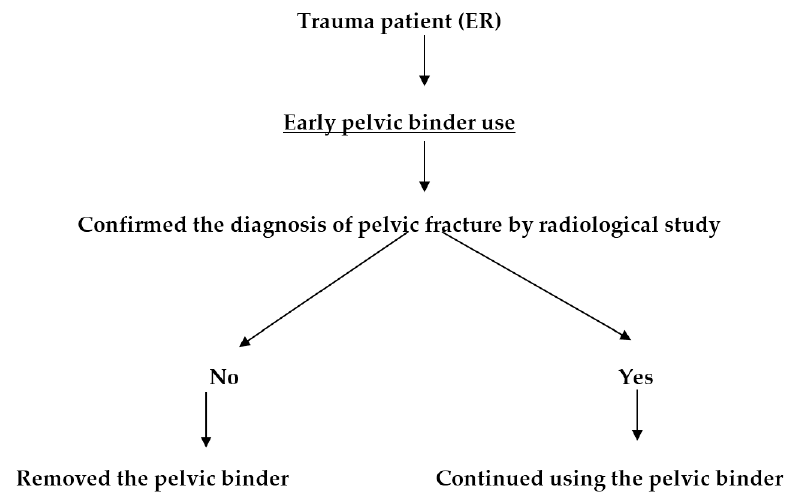
Figure 1. An updated protocol emphasizing the early use of a pelvic binder for trauma patients with suspected pelvic fracture. ER: Emergency Department.